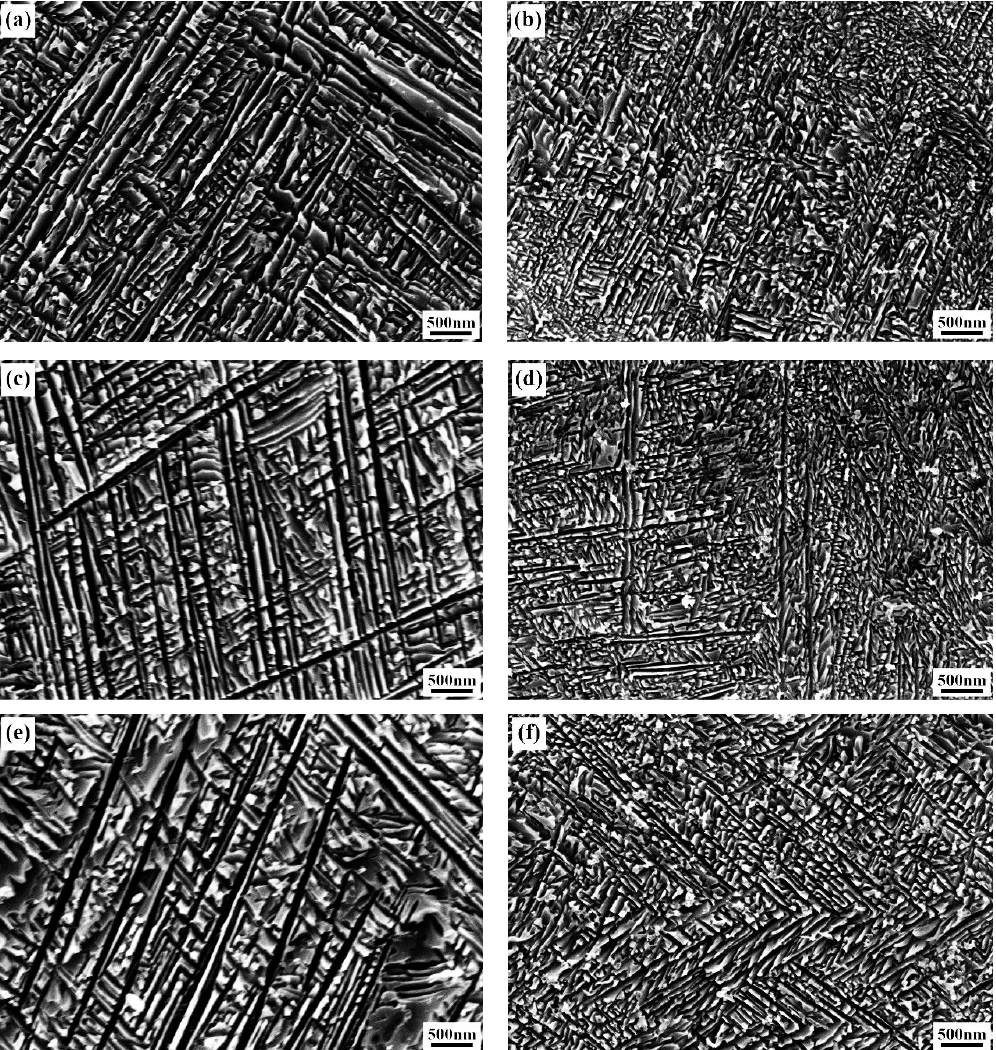
Figure 8. SEM micrographs of Ti–3.5Al–5Mo–4V alloy solution-treated at ( a , c , e ) 850 °C and ( b , d , f ) Figure8. SEMmicrographsofTi–3.5Al–5Mo–4Valloysolution-treatedat( a , c , e )850 ◦ Cand( b , d , f )1050 ◦ 1050 °C, then isothermally aging-treated at 500 °C for ( a , b ) 8 h, ( c , d ) 16 h, and ( e , f ) 48 h.